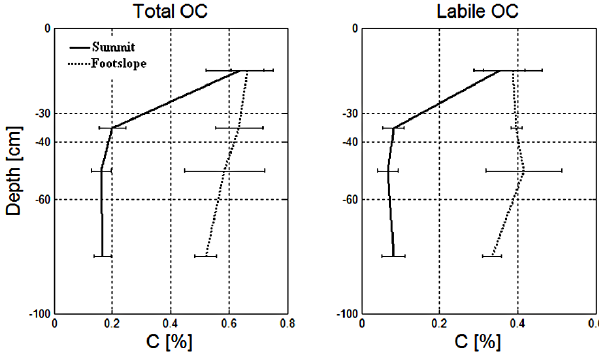
Figure 1. Soil profiles (0–100cm) of both soil total OC and labile OC pool concentrations [C%], at the summit and footslope posi- tions. Error bars indicate standard deviation ( n ≥ 3).